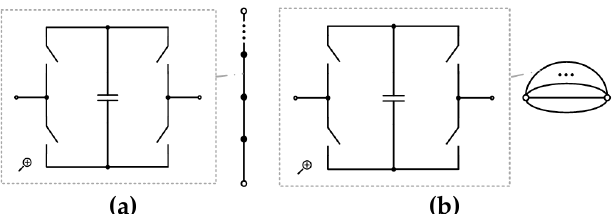
Figure 1. Schematic diagrams of ( a ) cascaded-bridge converters; ( b ) multi-paralleled converters.